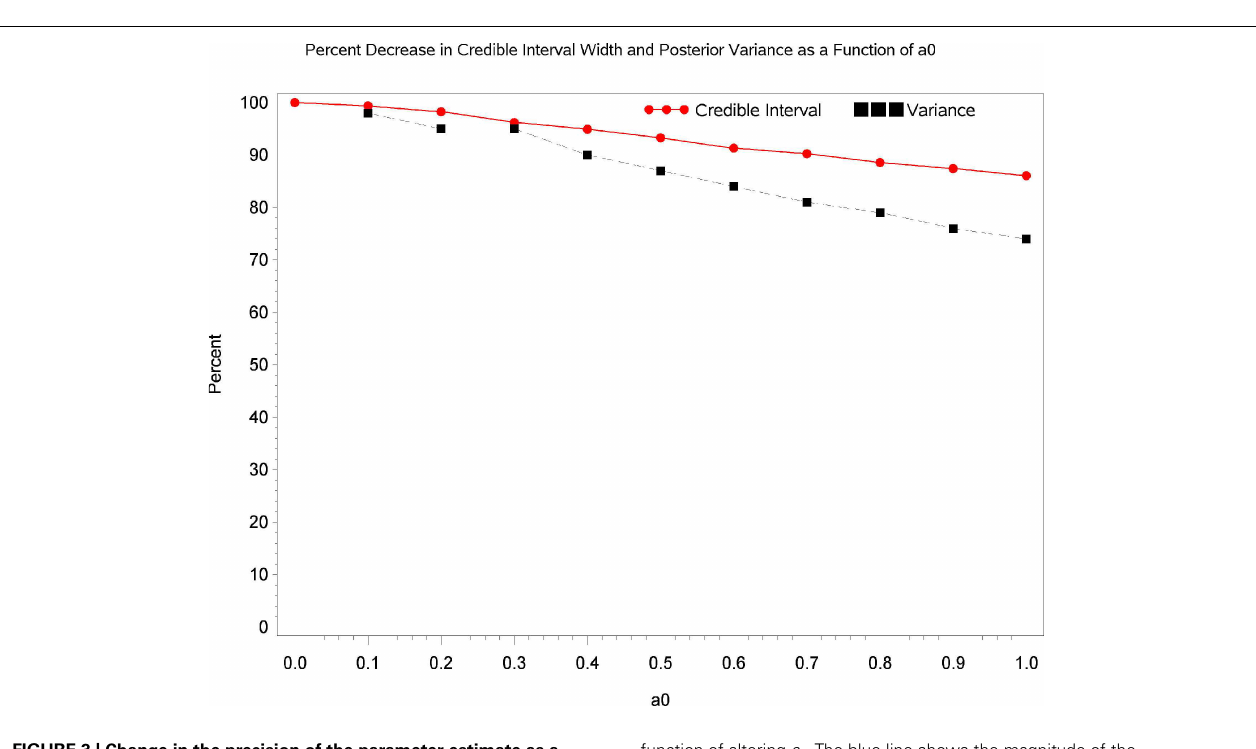
FIGURE 3 | Change in the precision of the parameter estimate as a function of a 0 . The red line shows the magnitude of the decrease in the Credible Interval range as a percentage of its width at a 0 = 0, as a